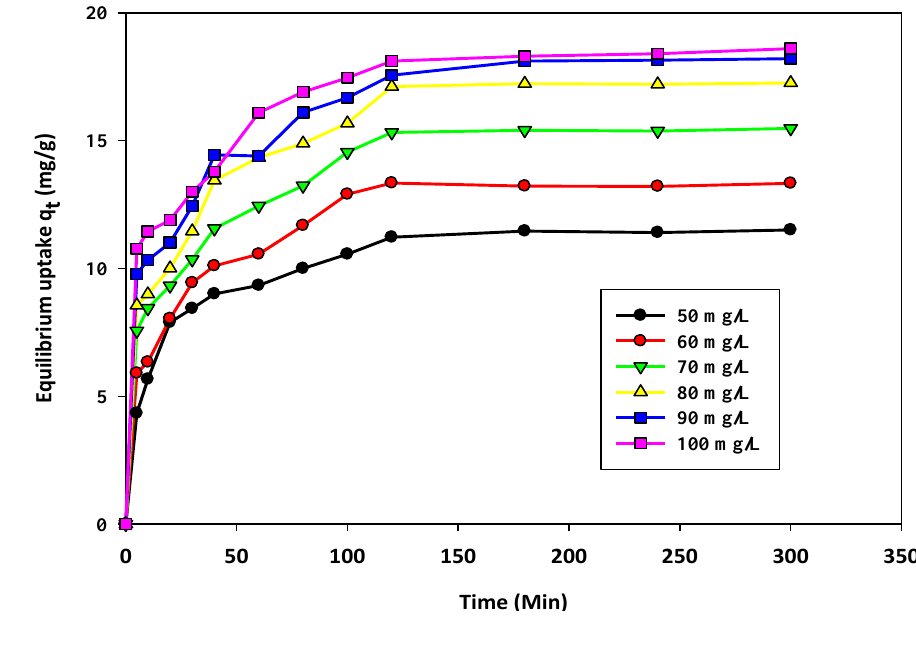
Figure 2. The effect of concentration with contact time and equilibrium